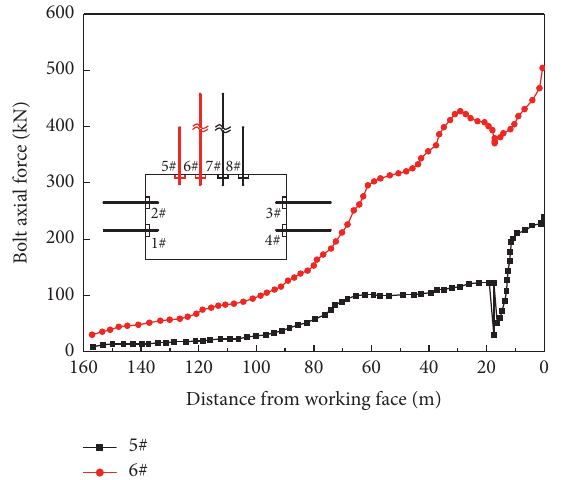
Figure 20: Nonhydraulic fracturing section: stress of the anchor cable at coal pillar side of 5# station.